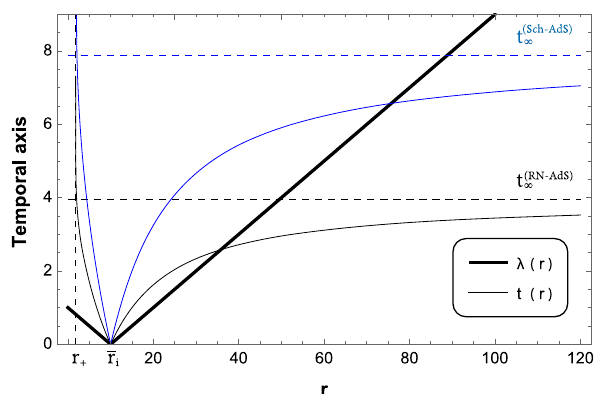
Fig. 2 Plot of the radial motion of massless particles. Particles moving to the event horizon, r + , cross it with a finite affine parameter, but an external observer will see that photons take an infinite (coordinate) time to do it. Here we have used the values E = 100, (cid:4) = 10, and ¯ r i = 10. Black-thin line for Q = 1 . 2, and r + ≈ 1 . 80. Blue line for Q = 0, and r + ≈ 1 . 96